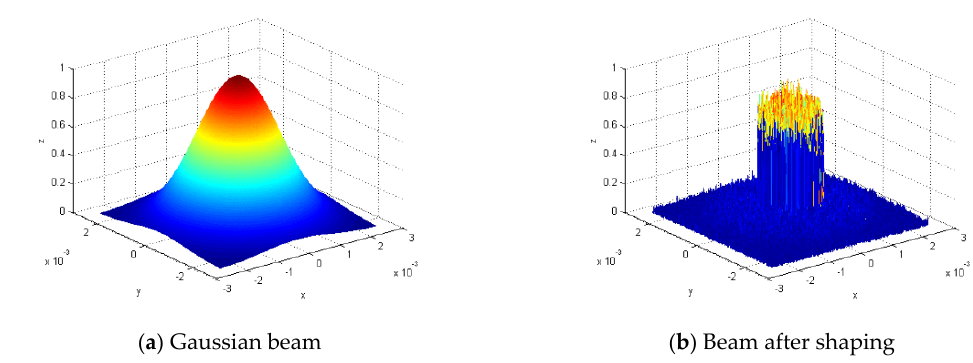
Figure 17. ( a,b ) Shaping of a Gaussian beam.